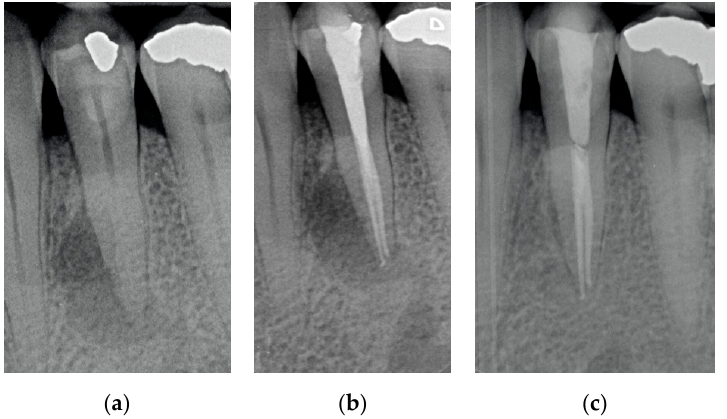
Figure 2. ( a ) A lower bicuspid in need to be endodontically treated because of necrosis of the pulp and periapical lesion; ( b ) The tooth after being endodontically treated. Two canals were found, cleaned and filled; ( c ) The tooth at 2 years recall. The periapical lesion completely disappeared.